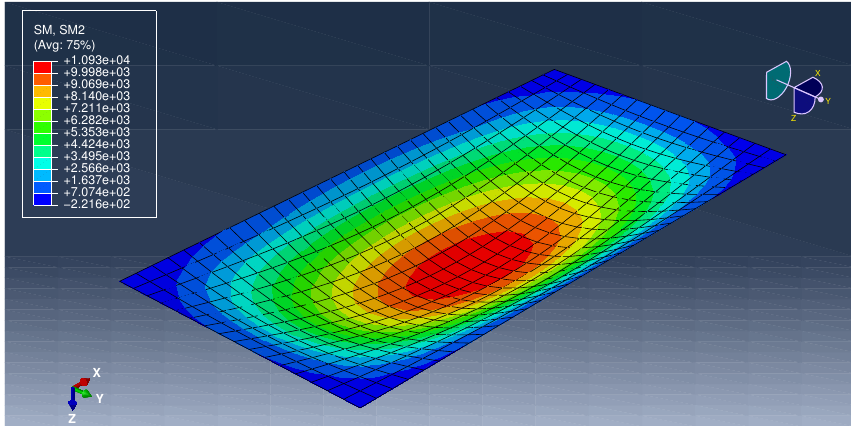
Figure A6. The bending moment M 22 of a simply supported rectangular plate solved using FEM.